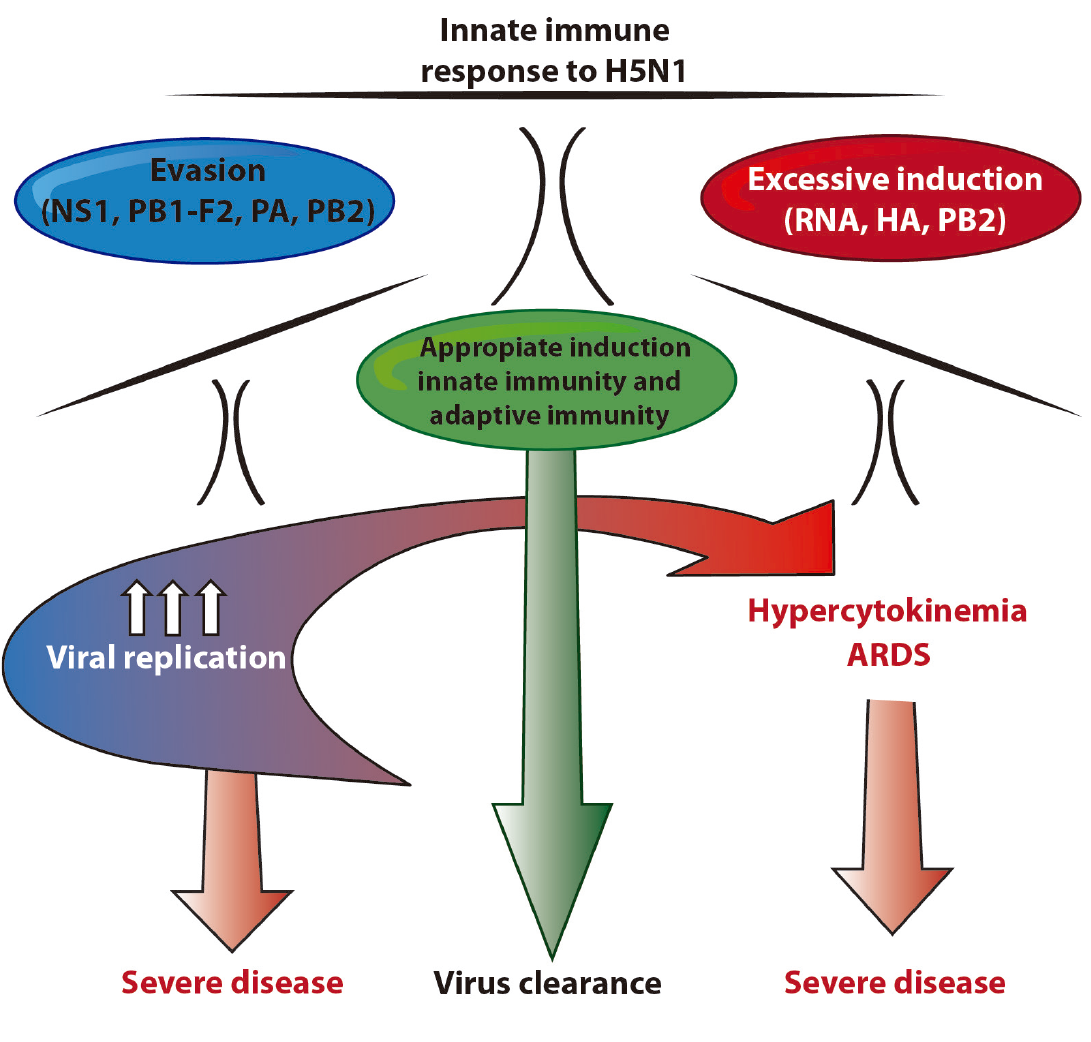
Figure 3. Induction of hypercytokinemia by H5N1 influenza viruses results from an imbalanced innate immune response. H5N1 influenza viruses are able to dysregulate the innate immune response, either by inducing high production of cytokines or by inhibiting the antiviral response. The evasion of the innate immunity might have as a consequence increased levels of viral replication, which contributes to increased PAMPs detection and cytokine induction. A combination of these events in vivo might explain how H5N1 innate immunity antagonists contribute to hypercytokinemia development in